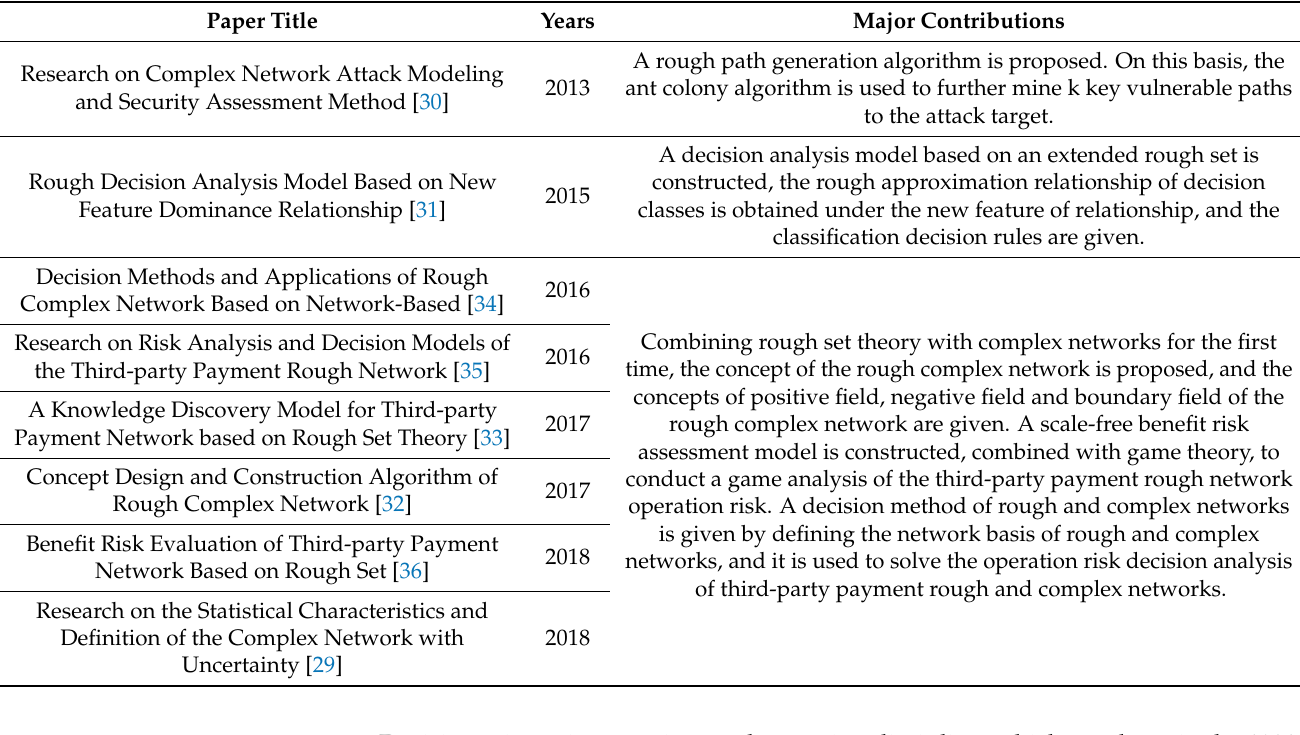
Table 2. Modeling of rough set theory in decision-making